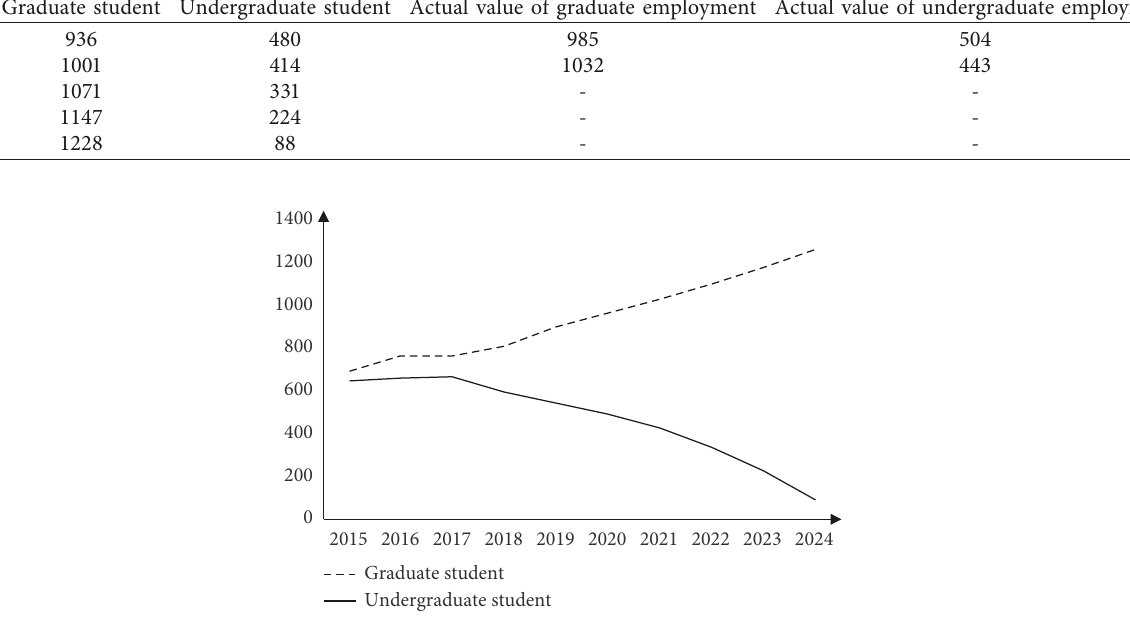
Figure 1: The employment trend in the aerospace and other defense-related